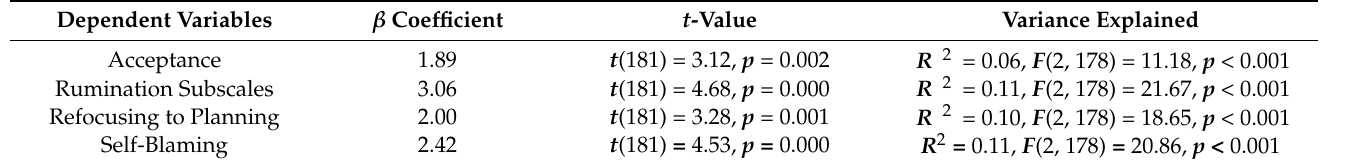
Table 1. Dependent variables that were significantly associated with foster care status.